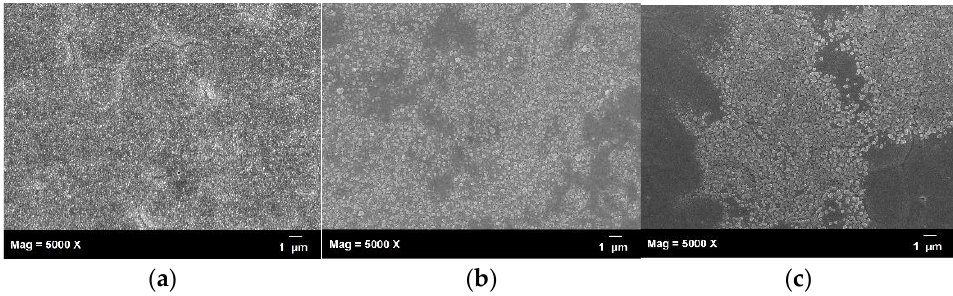
Figure 6. SEM images of the NPS-AuFON under different conditions—( a ) CV 2, ( b ) CV 3, and ( c ) CV 6.